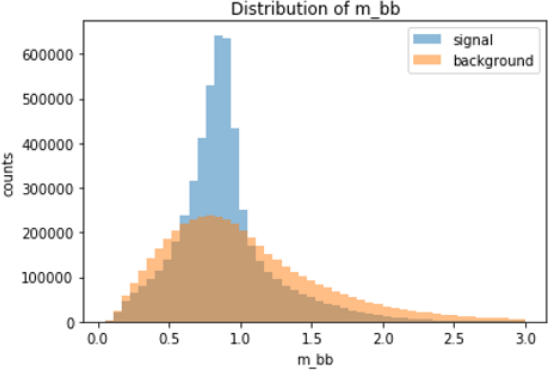
Figure 1. The invariant mass distribution (denoted as m bb ) of the two reconstructed b quarks for signal (blue) and background (orange)